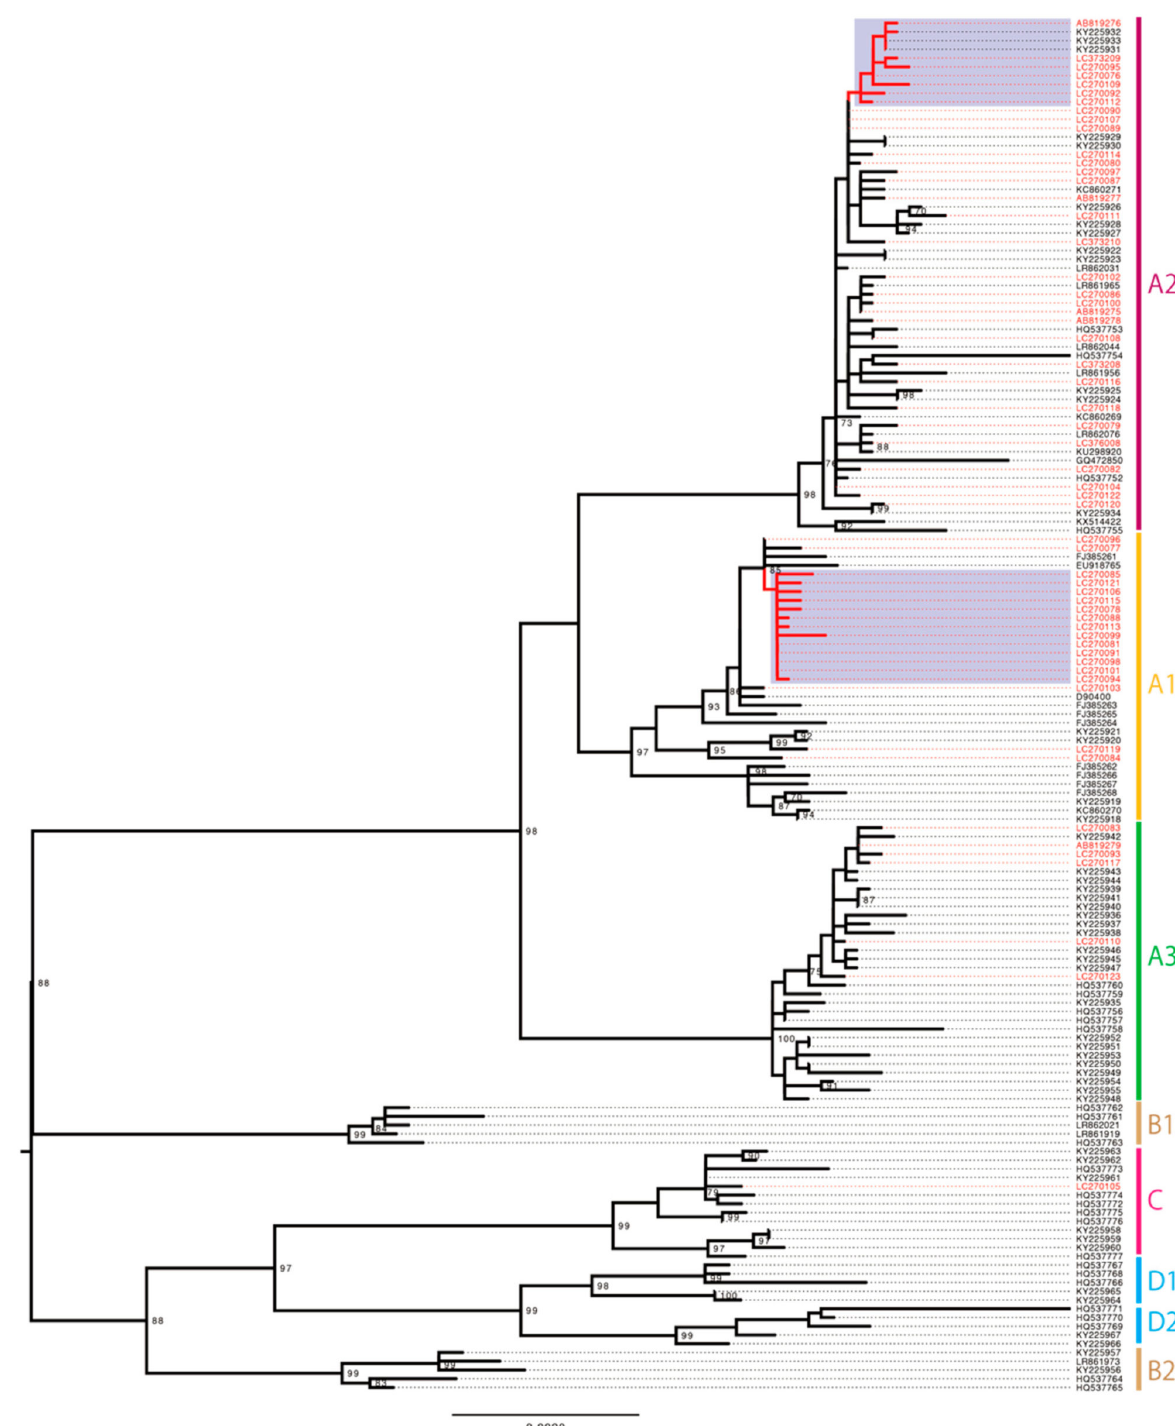
Figure 3. Maximum likelihood phylogenetic tree of complete HPV58 genomes available from Gen- Bank (https://www.ncbi.nlm.nih.gov/genbank/, accessed date: 31 August 2021). A total of 157 se- quences were analyzed in RAxML with 1000 bootstrap replicates. Bootstrap values >70% are dis- played. Red taxa indicate 57 sequences from Japan. Purple area marks the Japan-specific cluster of the sublineages A1 and A2. Scale bar, nucleotide substitutions per